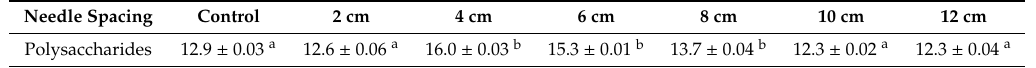
Table 2. Polysaccharide content (g/100 g) under different needle spacings.